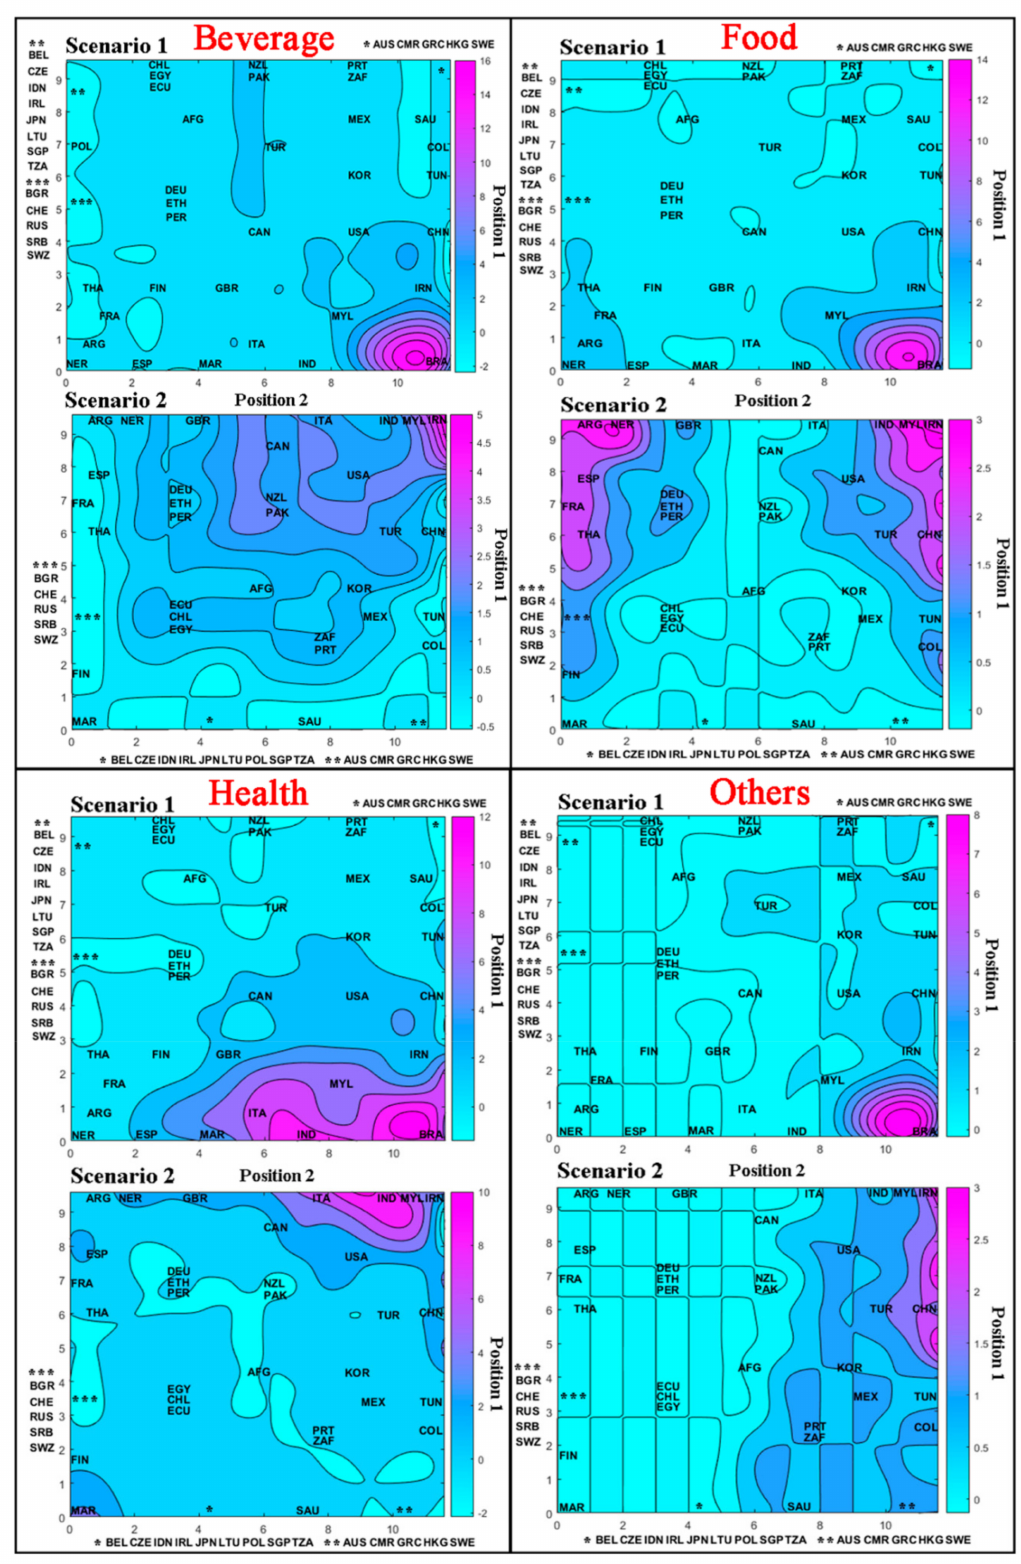
Figure 4. Weight maps overlaid by topological maps for the variables: countries. Position 1 and Position 2 indicate the position of the winning